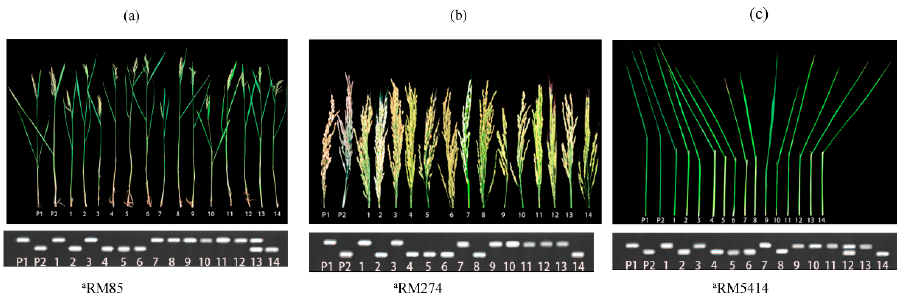
Figure 2. Main stem, panicle, flag leaf, and corresponding molecular markers of 14 different plant types in F 9 RILs of Gr 89-1 × Shuhui 527; ( a ) main stem; ( b ) panicle; ( c ) flag leaf; P1 represents Gr 89-1; P2 represents Shuhui 527; the numbers (1–14) represent 14 different plant types in F 9 RIL S of Gr 89-1 × Shuhui 527.